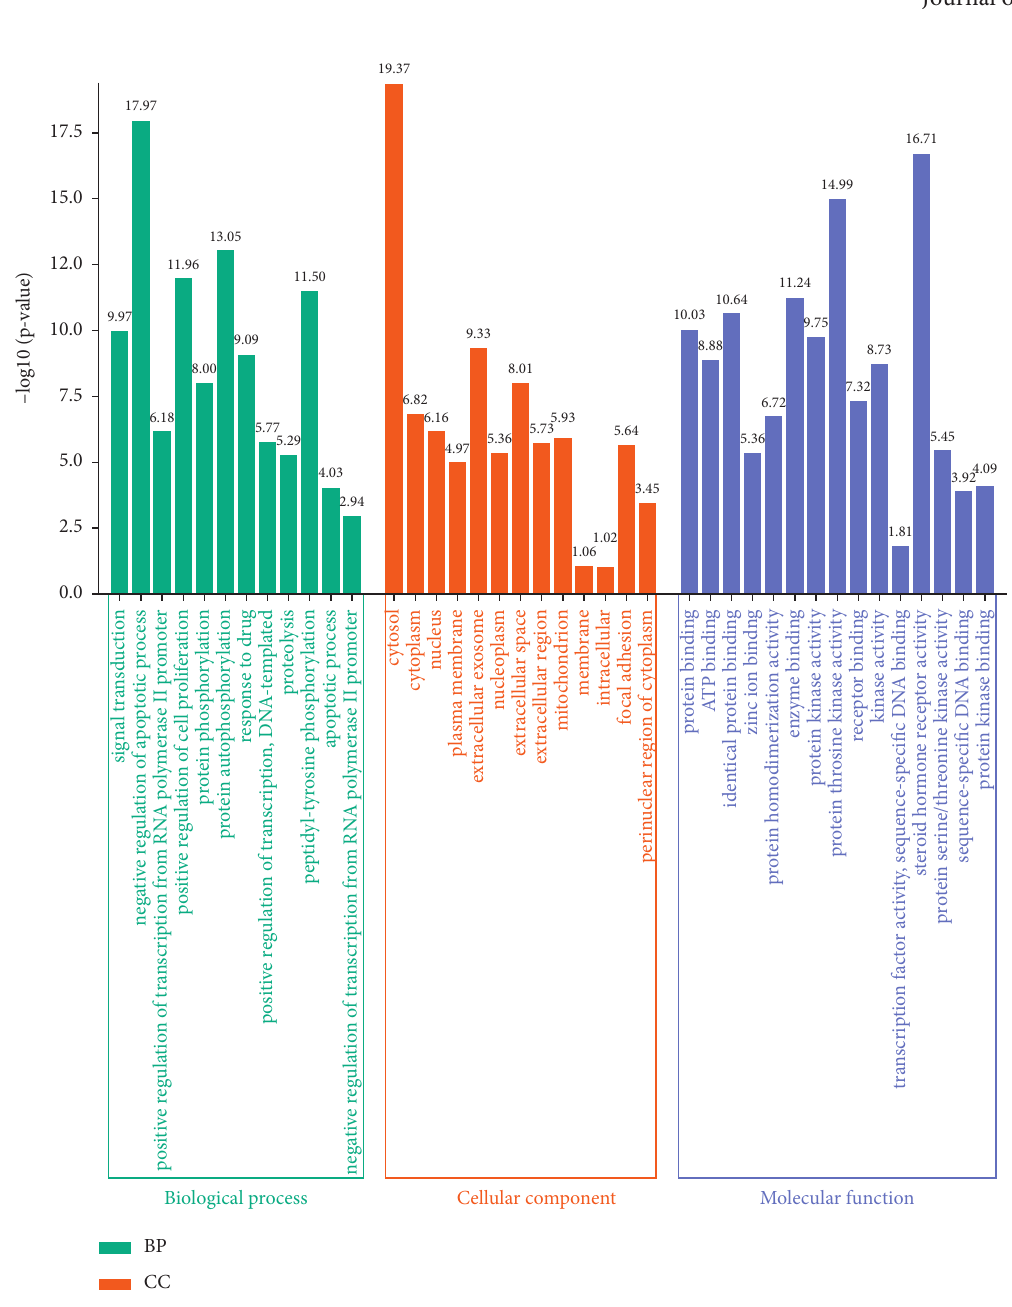
Figure 12: Enrichment analysis of GO function for key